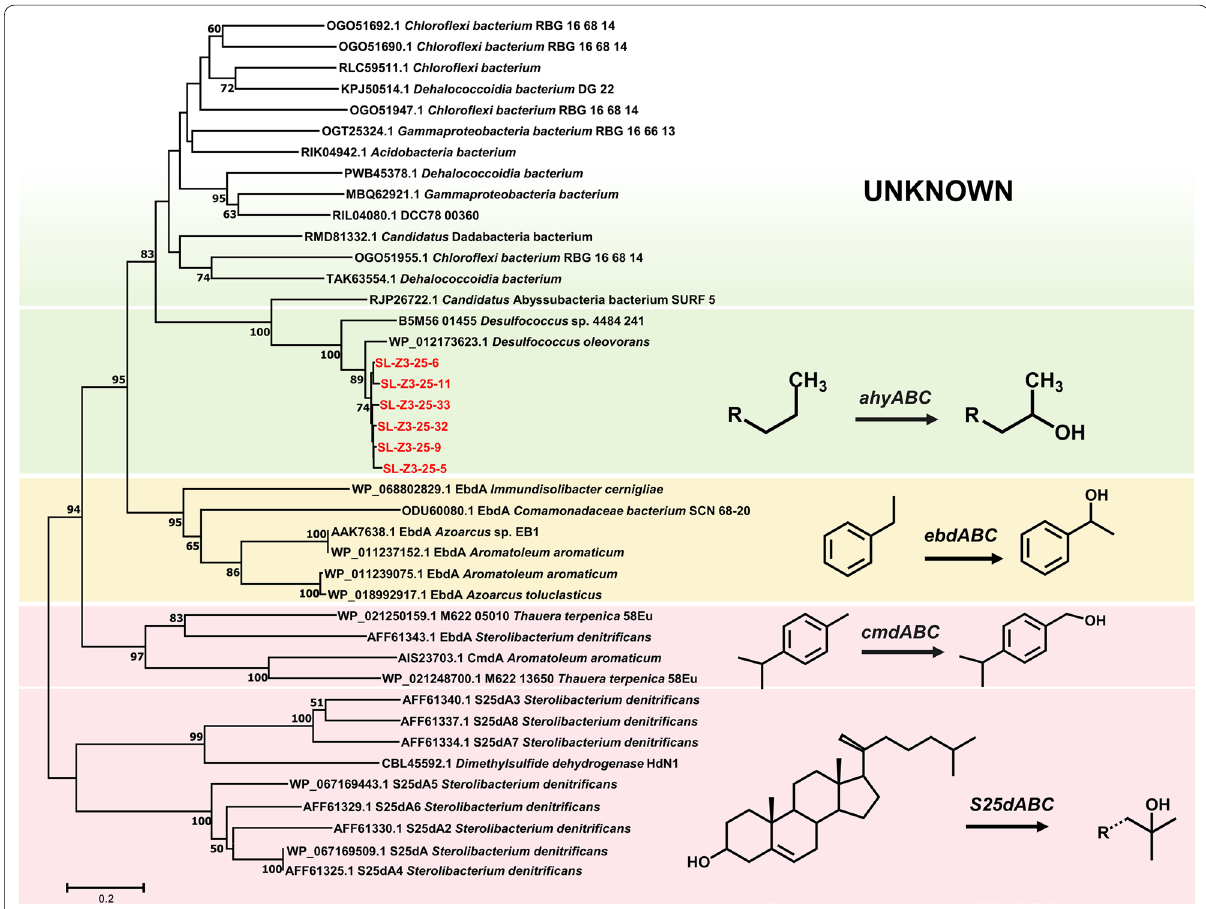
Fig. 2 Bootstrapped neighbour‑joining phylogeny of ahyA and selected Mo‑dependent hydroxylase gene sequences (outgroup not shown here). The sequences retrieved in this study are shown in red. Bootstrap support (1,000 replicates) > 50% is indicated at the nodes. The scale bar represents 20% amino acid sequence